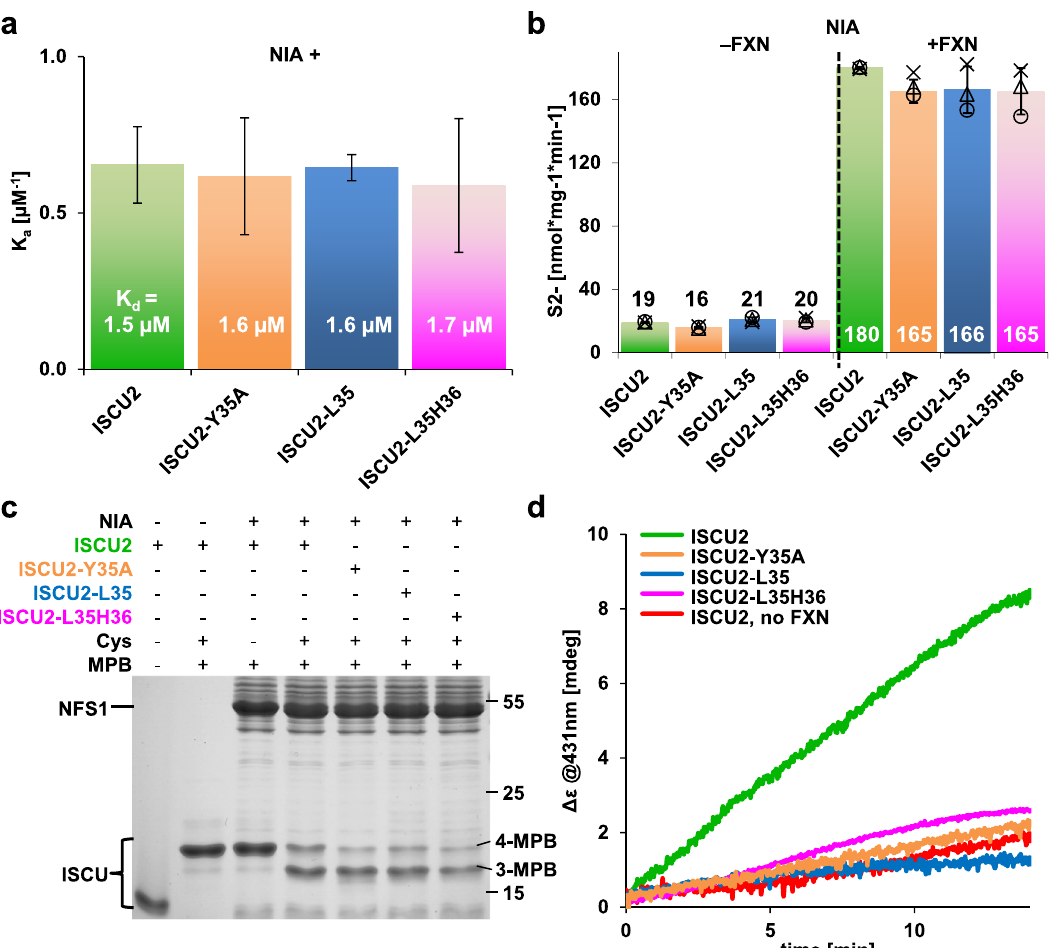
Fig. 4 Crucial role of Tyr35 of ISCU2 in late but not early steps of core ISC complex function. a Af fi nities of the indicated ISCU2 proteins for wild-type (NIA) 2 were measured by microscale thermophoresis (the data for wild-type ISCU2 was taken from Fig. 3a). The numbers within the bars represent K d values (error bars represent SD of the fi t using three independent experiments, Supplementary Fig. 8a). b Determination of DTT-mediated sul fi de (S 2- ) production by the (NIA) 2 complex in the presence of the indicated ISCU2 proteins without and with FXN after 20 min of incubation ( n = 3 biological replicates, individual data points are shown, error bars show SD). c Persul fi de transfer from NFS1 onto the indicated ISCU2 proteins was assayed as in Fig. 3c. d Enzymatic [2Fe-2S] cluster reconstitution (cf. Fig. 3d) of the indicated ISCU2 proteins with wild-type (NIA) 2 . Source Data are provided as a Source Data fi